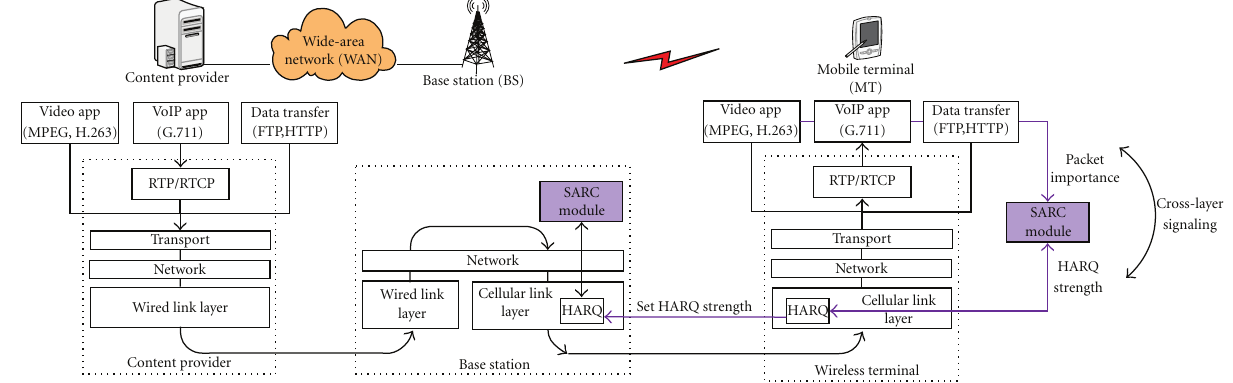
Figure 1: Architectural principles of SARC in a 3G cellular network. Blocks and links highlighted in “blue” underline the modules and signaling links employed by SARC approach.